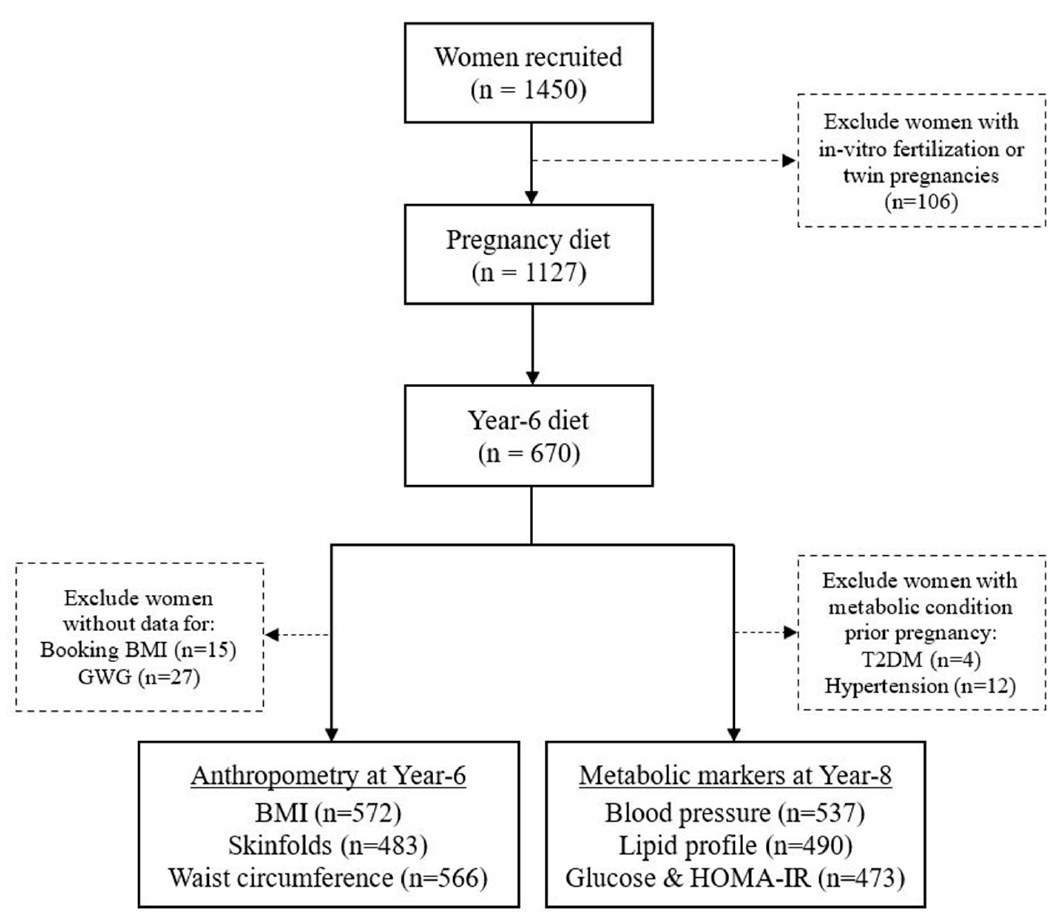
Figure 1. Participant flowchart. BMI, body mass index; GWG, gestational weight gain; HOMA-IR, homeostasis model assessment of insulin resistance; T2DM, type-2 diabetes mellitus.